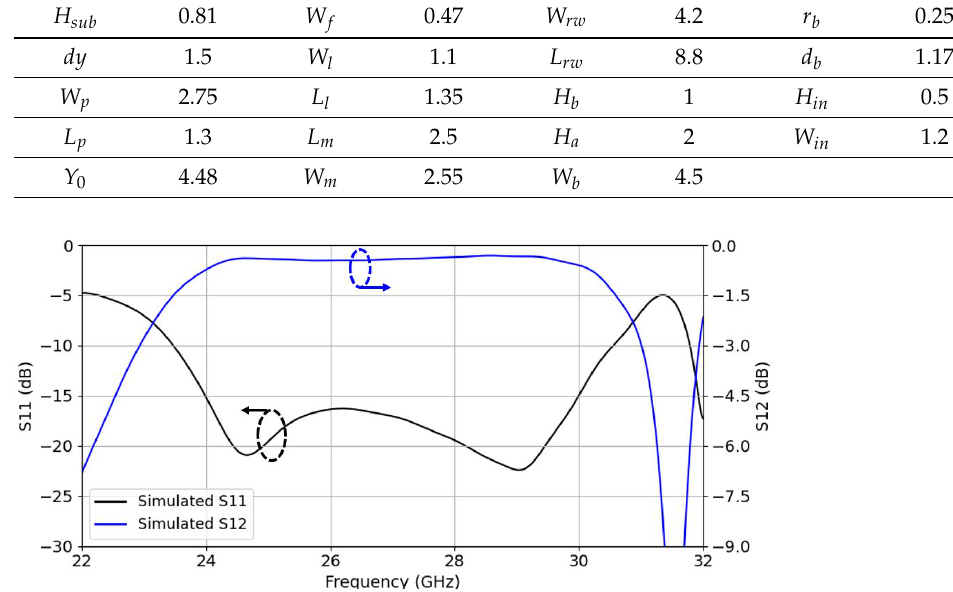
Figure 3. S-parameters of the single